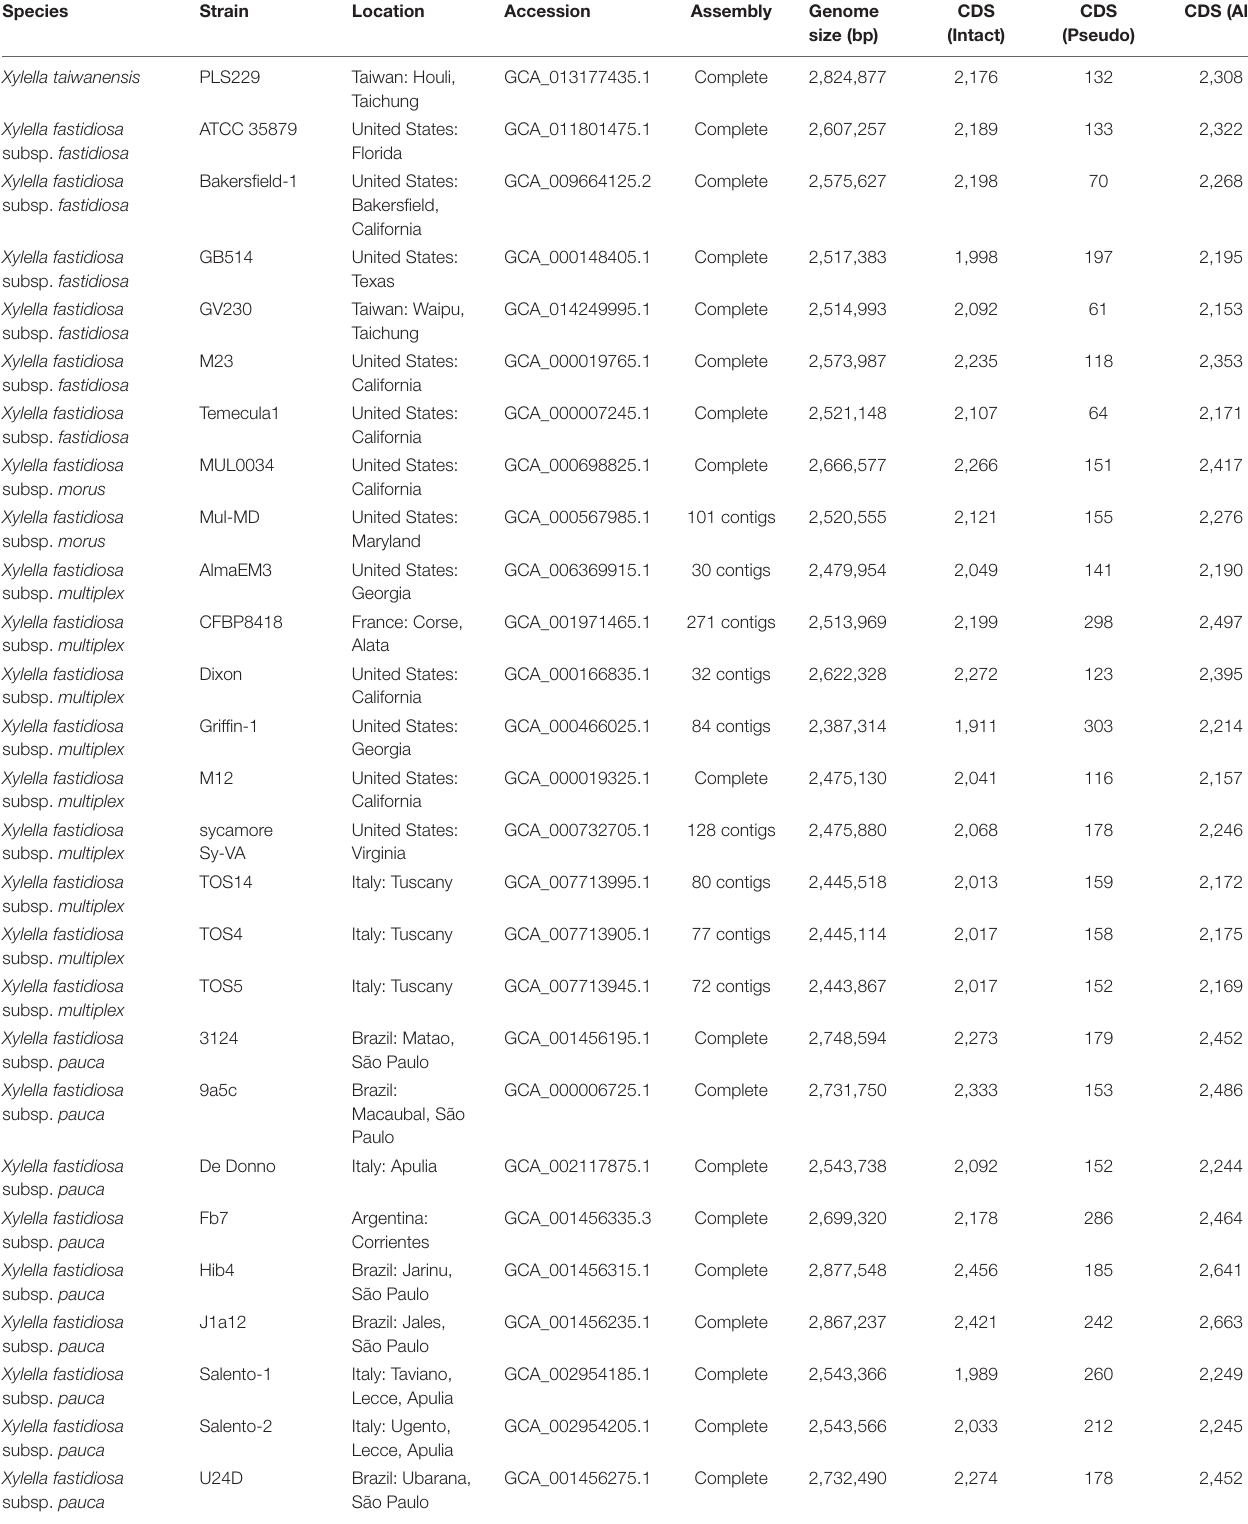
TABLE 1 | List of the genome sequences analyzed. Species Strain Location Accession Assembly Genome